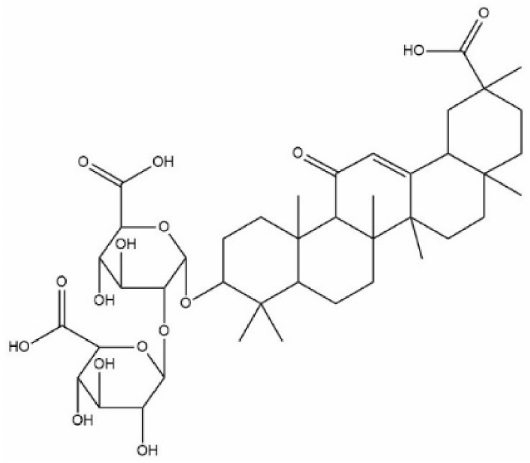
Figure 6. Chemical structure of glycyrrhizin.